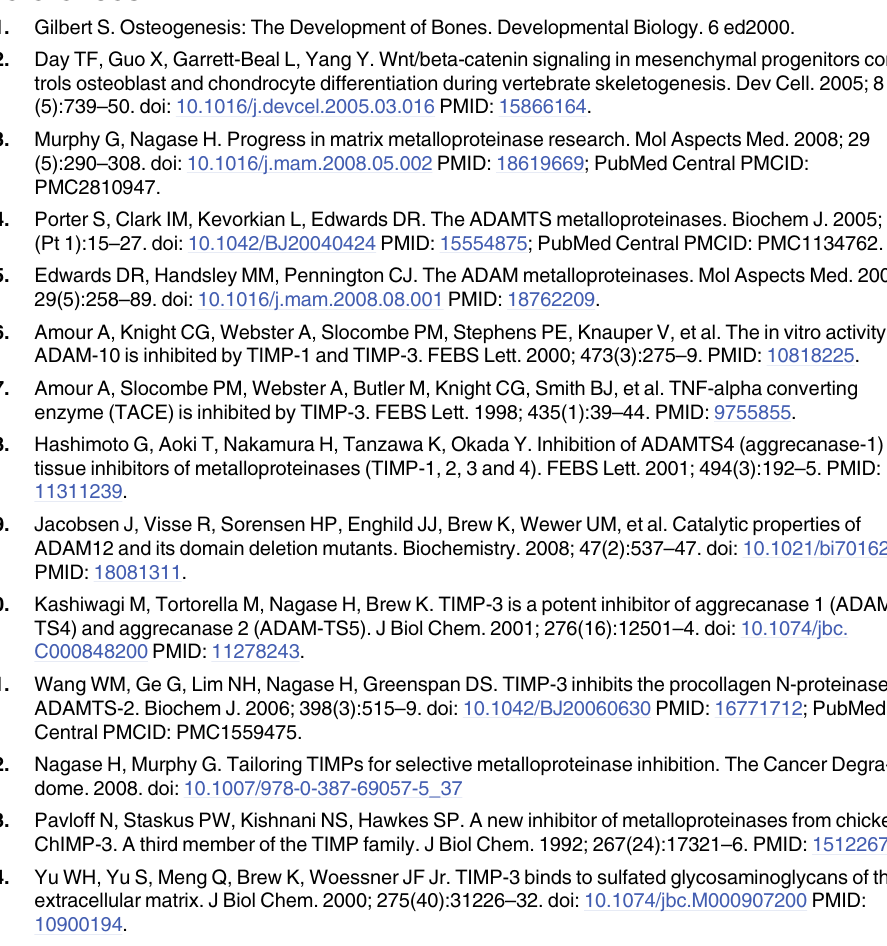
, Timp-3 KO, WT B6